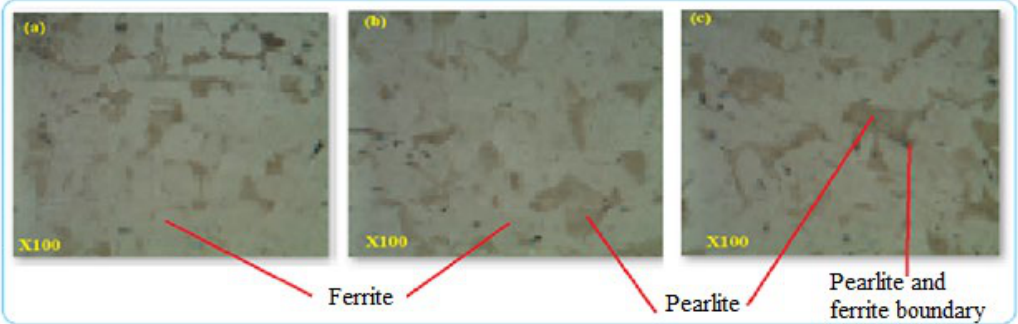
Figure 6. ( a – c ) Microstructures of GS pipe.